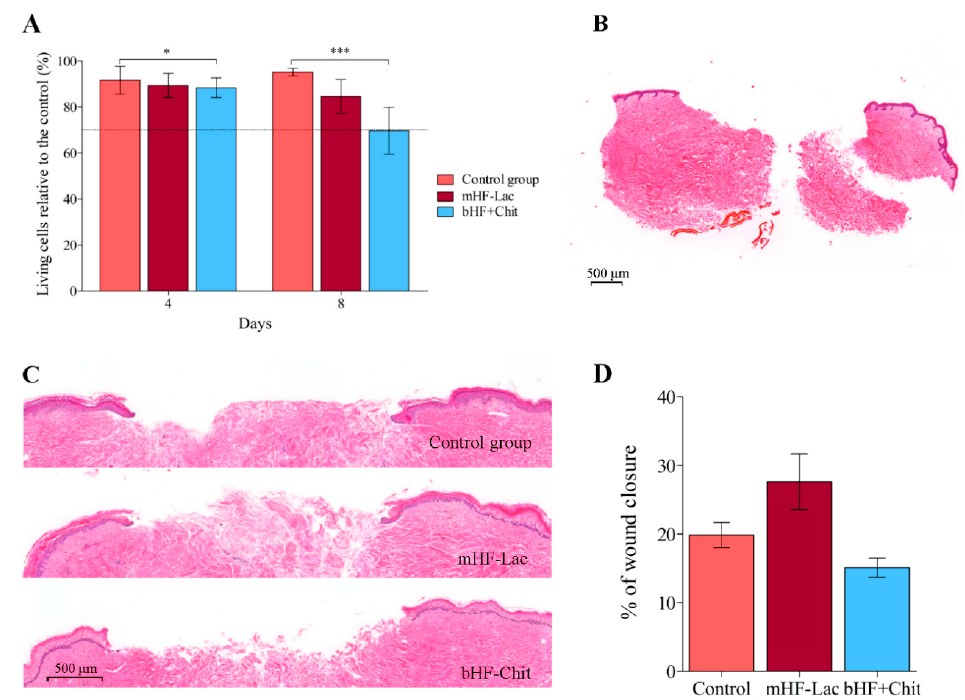
Figure 5. Ex vivo assay wound healing results. ( A ) LDH assay of the ex vivo assay. The results were represented as the viability of the three groups on different time points. * p < 0.05 comparing the control group and the group treated with bHF+Chit, on day 4; *** p > 0.001 comparing each group with the other two, on day 8. ( B ) Representative image of a tissue section stained with H&E on day 0. The scale bar indicates 500 µm. ( C ) Histological images of tissue sections of each group on day 8, processed with H&E. The scale bar indicates 500 µm. ( D ) Percentage of wound closure on day 8. Results are shown as the mean ± standard error of the mean.